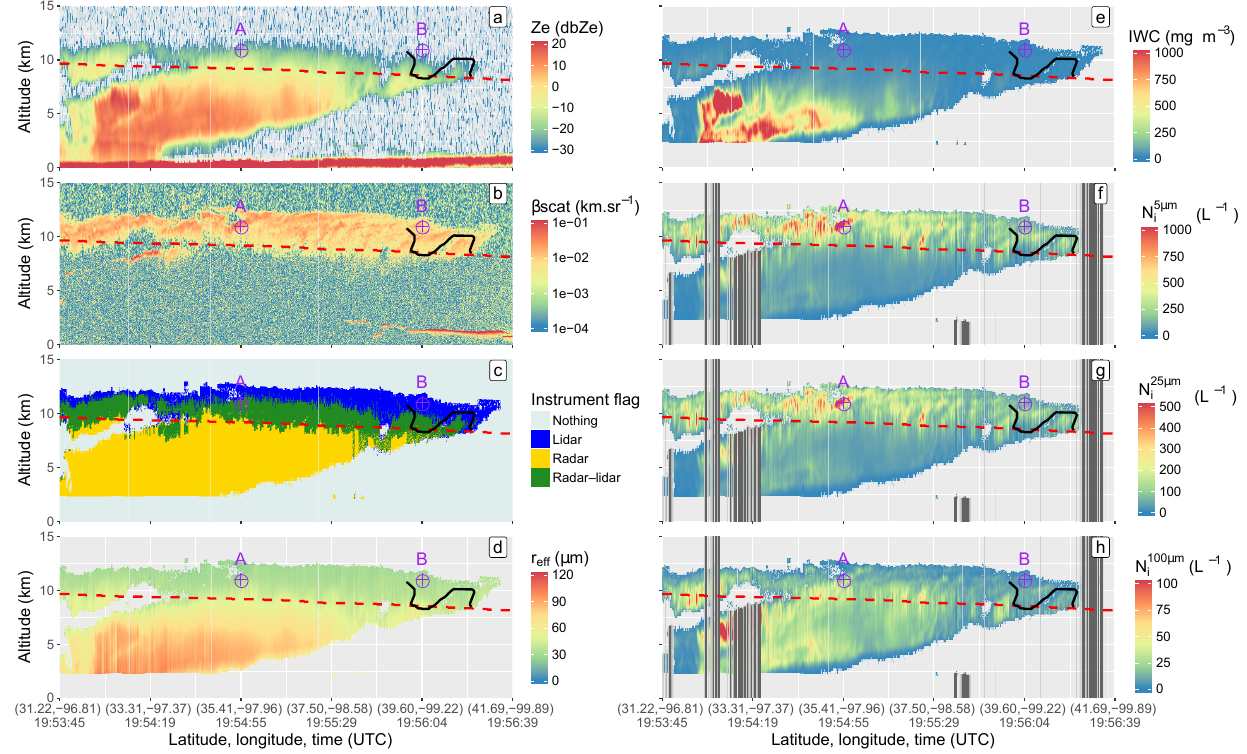
Figure 6. Vertical profiles of the (a) the CloudSat reflectivity factor, (b) the CALIOP backscatter coefficient, (c) the DARDAR instrument flag, (d) r eff , (e) IWC and (f–h) DARDAR-Nice N 5µm , N 25µm , and N 100µm , respectively, along the selected A-Train overpass (plain green i i i line in Fig. 5). Dark-grey shaded areas in (f) – (h) indicate a rejection of the retrievals (insufficient n iter or below a supercooled layer; see Sect. 3.1). The − 40 ◦ C isotherm is in dashed red, the location of the A and B air parcels are indicated in purple, and the Learjet 25 track is shown in black. and are shown as dashed and plain purple lines, respectively, in Fig. 5a. The corresponding altitudes are similarly indicated as function of time in Fig. 5c–d. Complementarily, the ver- tical cross sections of vertical wind velocities ( w ) predicted by NARR along the trajectories are indicated by the colored background in Fig. 5c–d. Contours of the NARR IWC are shown in grey to serve as rough indicators of the presence of ice cloud layers in the model. It can be noted that NARR provides reanalyses with a horizontal resolution of 32 km, 29 vertical levels and 3-hourly outputs; therefore, the closest output times and grid-points were selected. It is observed that both air parcels originated from warm moist air over the Pacific and slowly ascended atop the cold continental air following northwesterly trajectories as- sociated with slow vertical motions (light brown colors), which is in agreement with expectations. Parcel B ascended from about 8 km at 08:00 UTC to 11 km at the overpass time (20:00 UTC) and then remained at a constant altitude. The − 40 ◦ C isoline (dashed red line) is crossed around 14:00 UTC and this parcel then appears to belong to an anvil- like maturing cloud layer from 19:00 UTC, supported by small w (less than 1 cm s − 1 ) observed around the